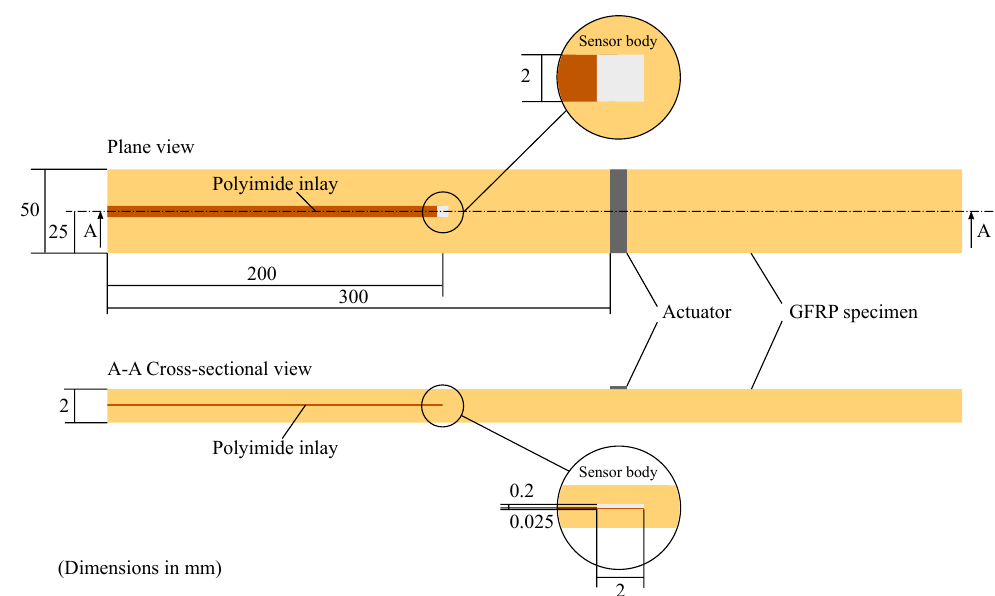
Figure 2. Sketch of the GFRP specimen design showing the dimensions, the polyimide inlay and an applied square dummy sensor body (cf. Figure 1) composed of the same borosilicate glass as the representative MEMS vibrometer [9] under investigation.